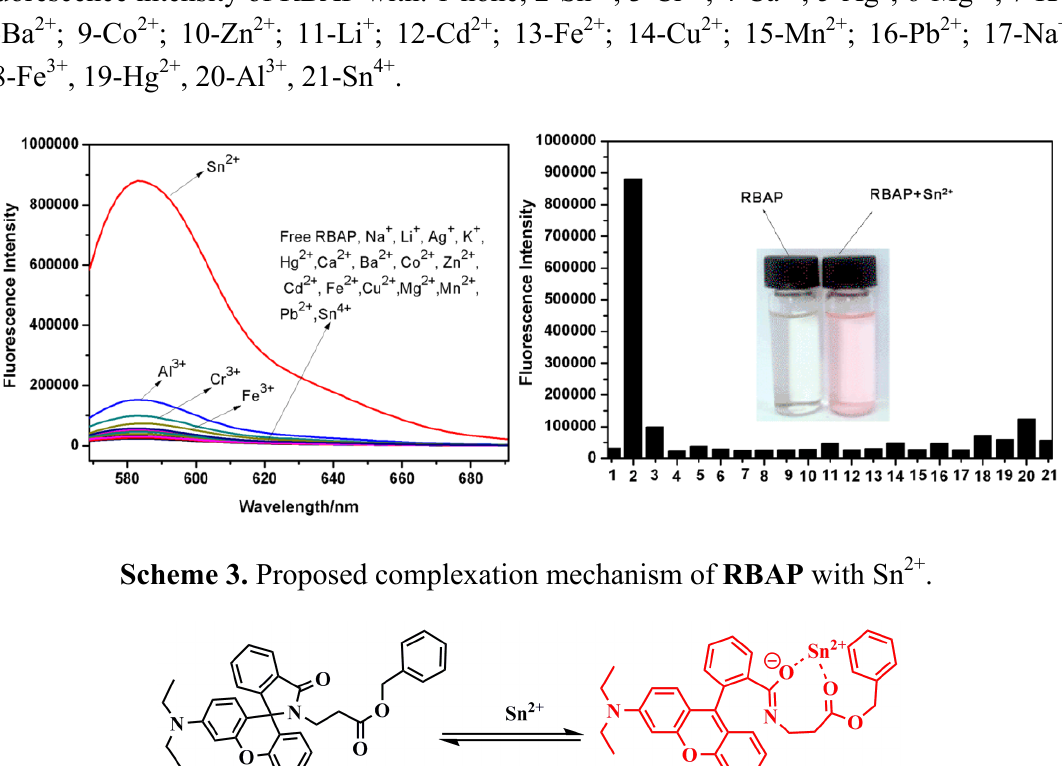
Figure 8. Fluorescence emission changes of RBAP (10 μ M) with metal cations (50 μ